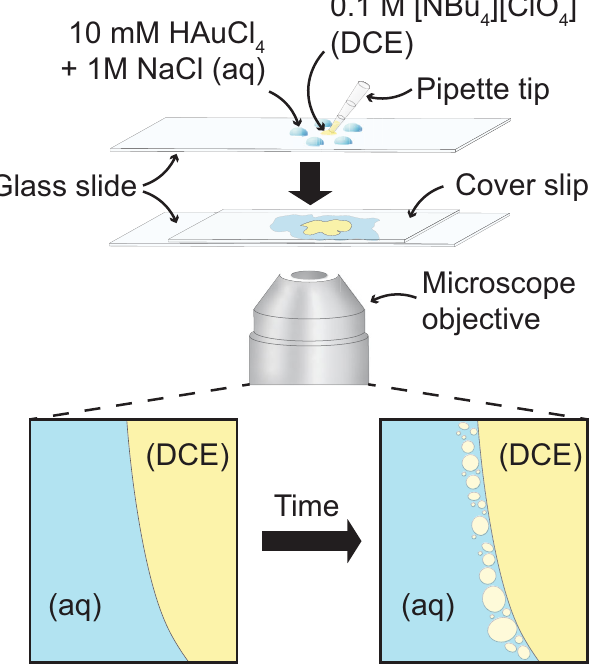
Fig. 1 | Overview of the experimental setup. Five 0.4 µ L droplets containing 10mM HAuCl 4 and 1M NaCl are pipetted onto a glass slide with a DCE droplet containing0.1M[NBu 4 ][ClO 4 ]pipettedintothecenter.Acoverslipisplacedontop of the droplets and transmission light microscopy shows the spontaneous emul- si fi cation and generation of DCE droplets in the aqueous phase over time.